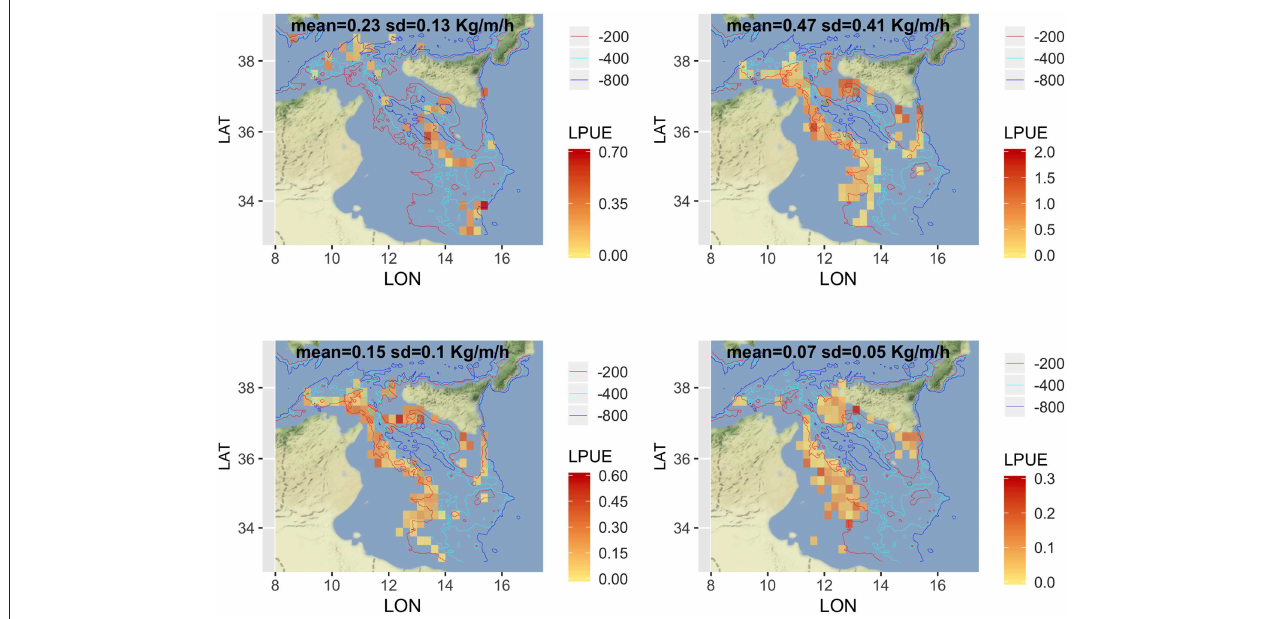
FIGURE 5 | Spatial distribution of LPUE (kg/m/h) by species, as the annual mean for the period 2012–2016. Figures were created using the R package ggmap (Kahle and Wickham, 2013 ) using Map tiles by Stamen Design, under CC BY 3.0 and data by OpenStreetMap contributors (2017).